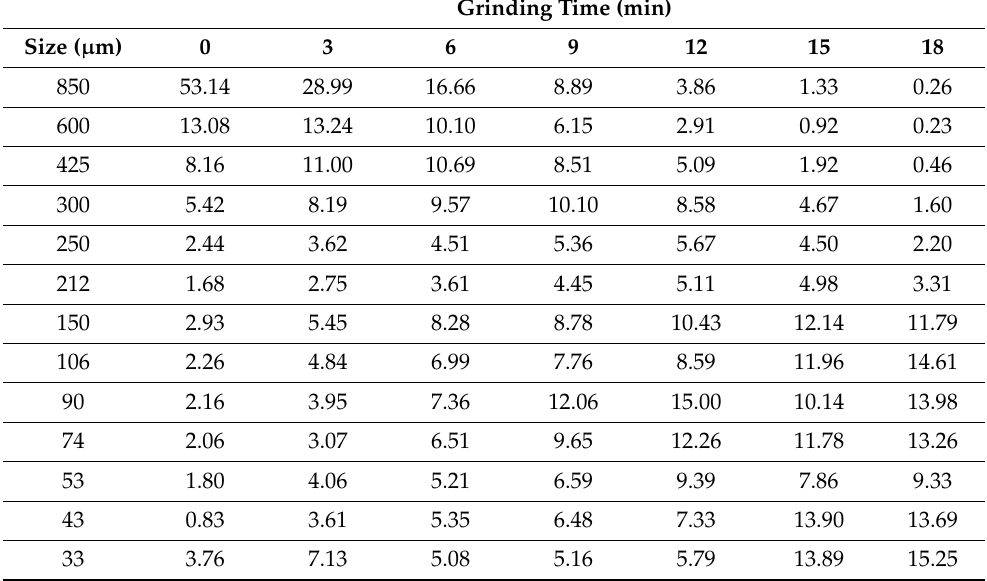
Table A1. Experimental data for the weight of each sizer (%) for LGP-1 ore-A.